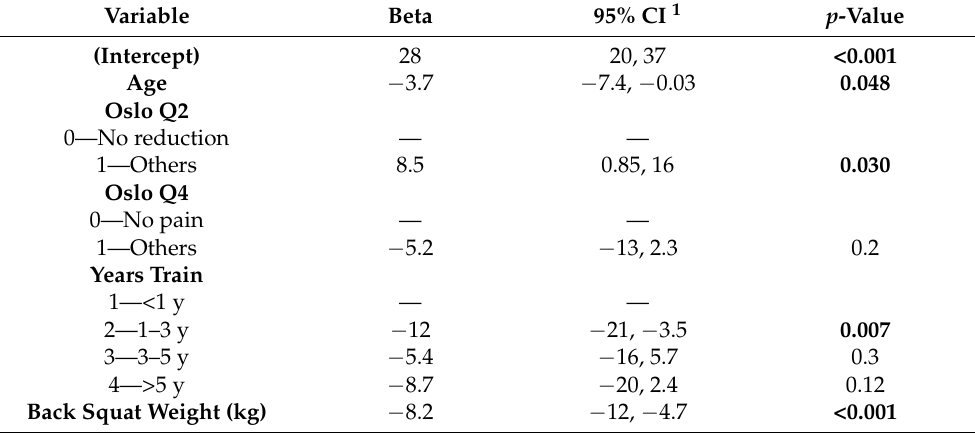
Table 2. Multiple Regression Analysis for the Relationship Between Variables and PHODA-SeV